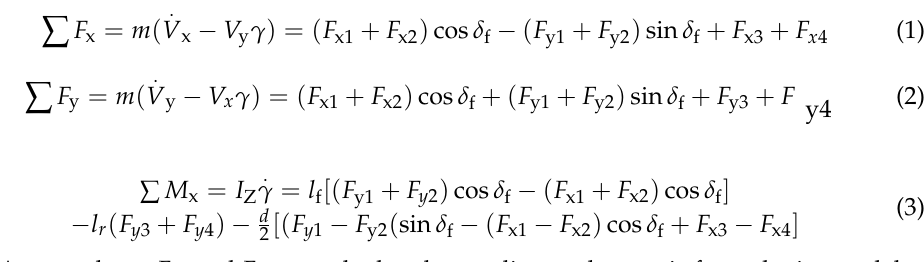
In Formulas (1)–(4), m is the mass of vehicle. I z is the inertia moment of vehicle. V x is the longitudinal velocity of vehicle. V y is the lateral velocity of vehicle. γ is the yaw rate. δ f is the front-wheel angle. l f is the distance from the center of gravity to front axle. l r is the distance from the center of gravity to rear axle. d is the wheelbase. F xi is the longitudinal forces of each wheel and F yi is the lateral forces of each wheel. Subscripts 1, 2, 3, and 4 indicate the left-front wheel, right-front wheel, left-rear wheel, and right-rear wheel respectively. λ i is the tire slip rate. α i is the sideslip angle of the tire. x 1x , x 2x , x 3x , and x 4x are the parameters determined by road conditions to get F xi . x 1y , x 2y , x 3y , and x 4y are the parameters determined by road conditions to get F yi